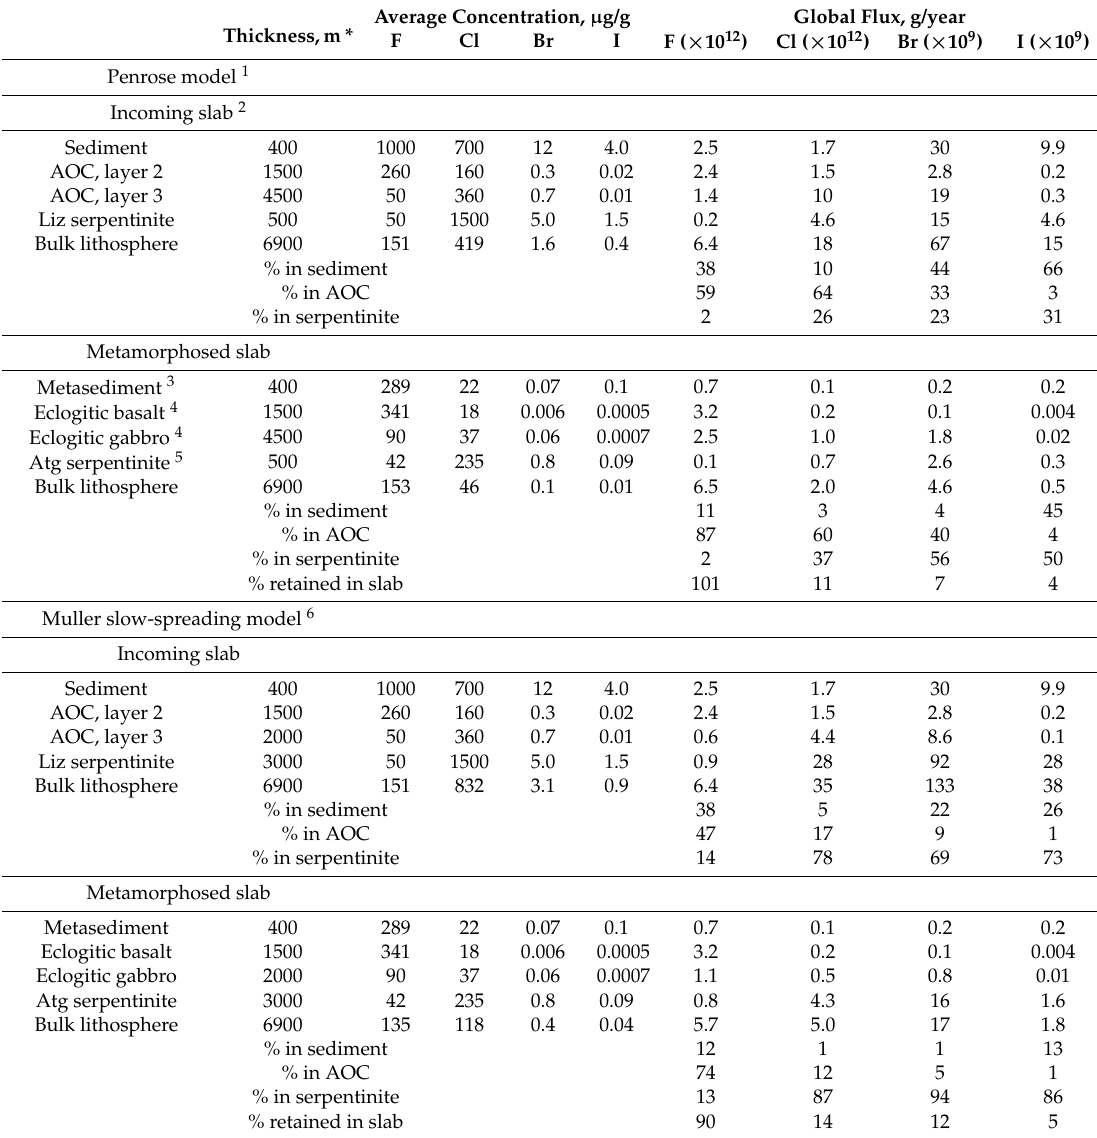
Table 1. Summary of global mass balance